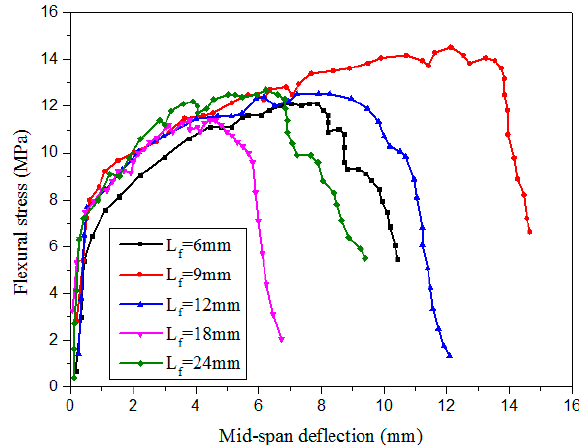
Figure 12. Effect of the PVA fiber length on the flexural strength vs. mid-span deflection curve of the matrix [72].